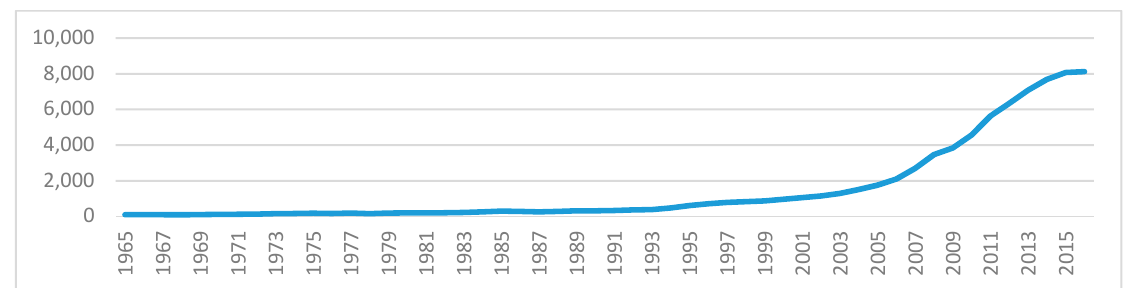
Figure 1. Time series plots of the variables used in this paper.